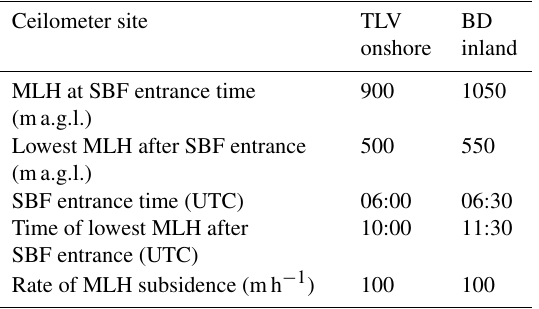
Table 3. Mixed layer height rate of subsidence on 20 August 2014. Table 4. Mixed layer height rate of subsidence on 13 August 2014.